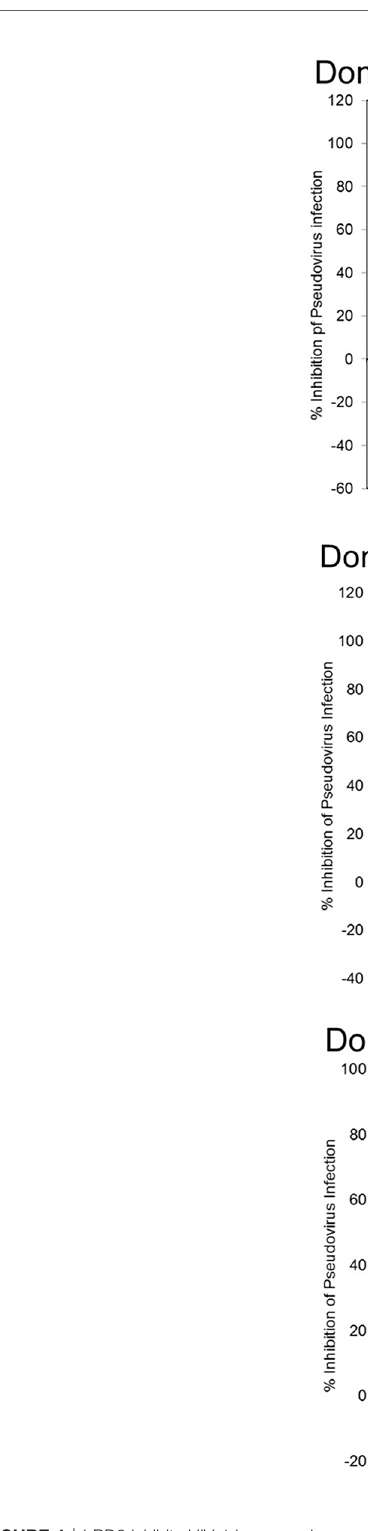
Frontiers in Cellular and Infection Microbiology |